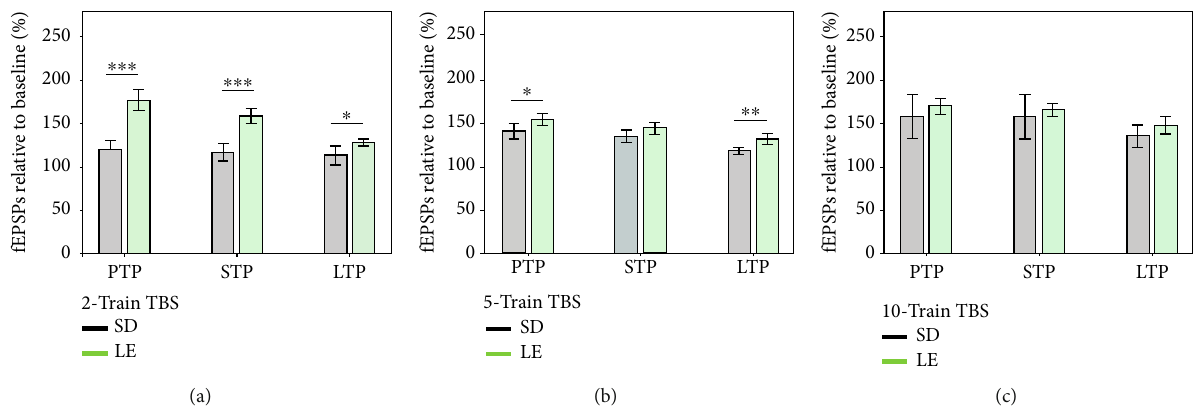
Figure 6: Comparison in PTP, STP, and LTP between SD and LE rats in (a) 2-train TBS, (b) 5-train TBS, and (c) 10-train TBS protocols. Results are shown as means ± 95 % confidence intervals . ∗ p value < 0 : 05 ; ∗∗ p value < 0 : 01 ; and ∗∗∗ p value < 0 : 001 14 : 228 % PQ10) (Figure 13(c)). A mixed-e ff ect model did not